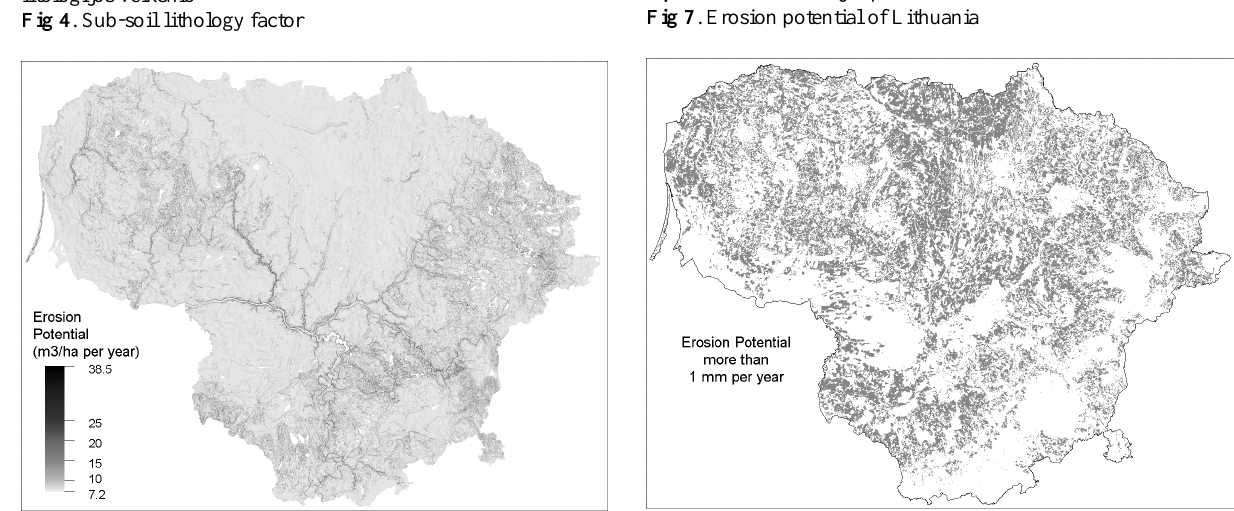
Fig 8 . Erosion potential higher than 1 mm per